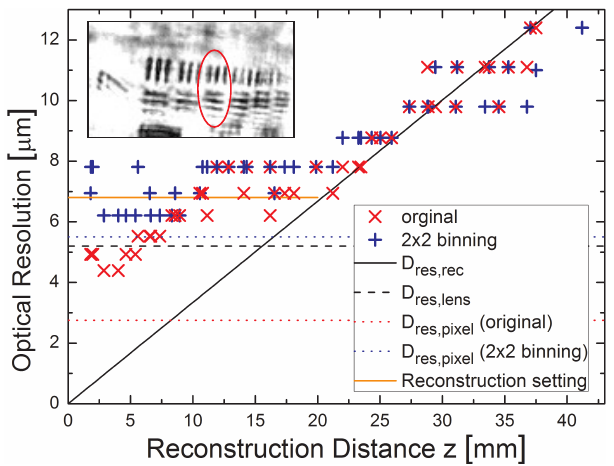
Fig. A1. Graph: measured optical resolutions of reconstructed holo- grams as a function of target distance. The lines indicate different theoretical optical resolution limits: D res,rec from the aperture an- gle of the reconstruction, D res,lens from the numerical aperture of the lens, and D res,pixel from the size of the pixels of the original and binned image. The orange line indicates the value the low-pass filter was set to during